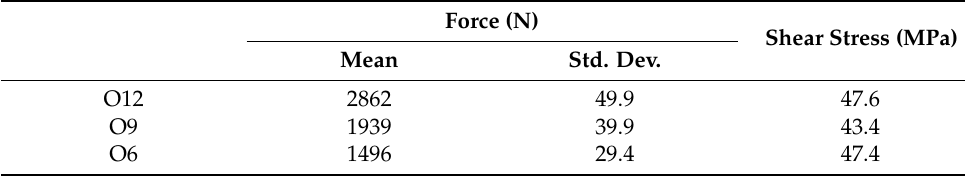
Figure 11. Shear stress distribution in the cross-sections. Table 2 contains the numerical values for each tested group. Table 2. Numerical results of the test.